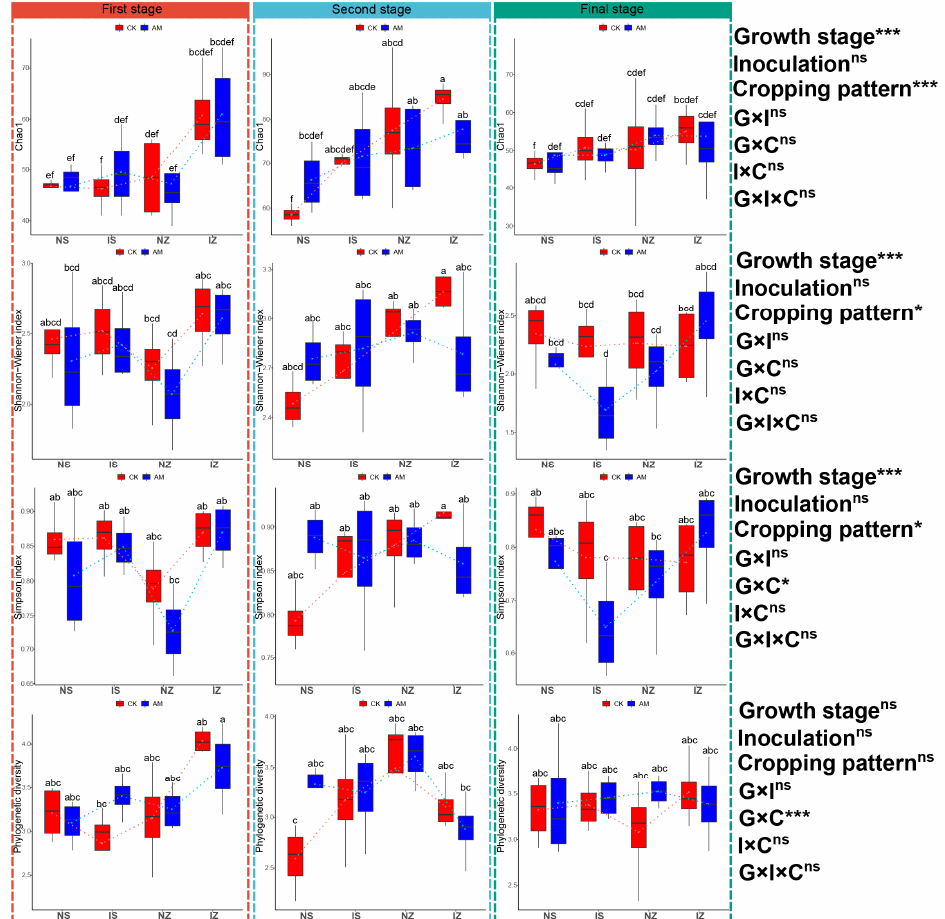
Figure 5. Differences in fungal Chao1, Shannon–Wiener index, Simpson index, and phylogenetic diversity under different treatments. Deviation bars represent standard deviation. Bars followed by lowercase letters are significantly different ( p < 0.05). ns: p > 0.05, *: p < 0.05, ***: p < 0.001.